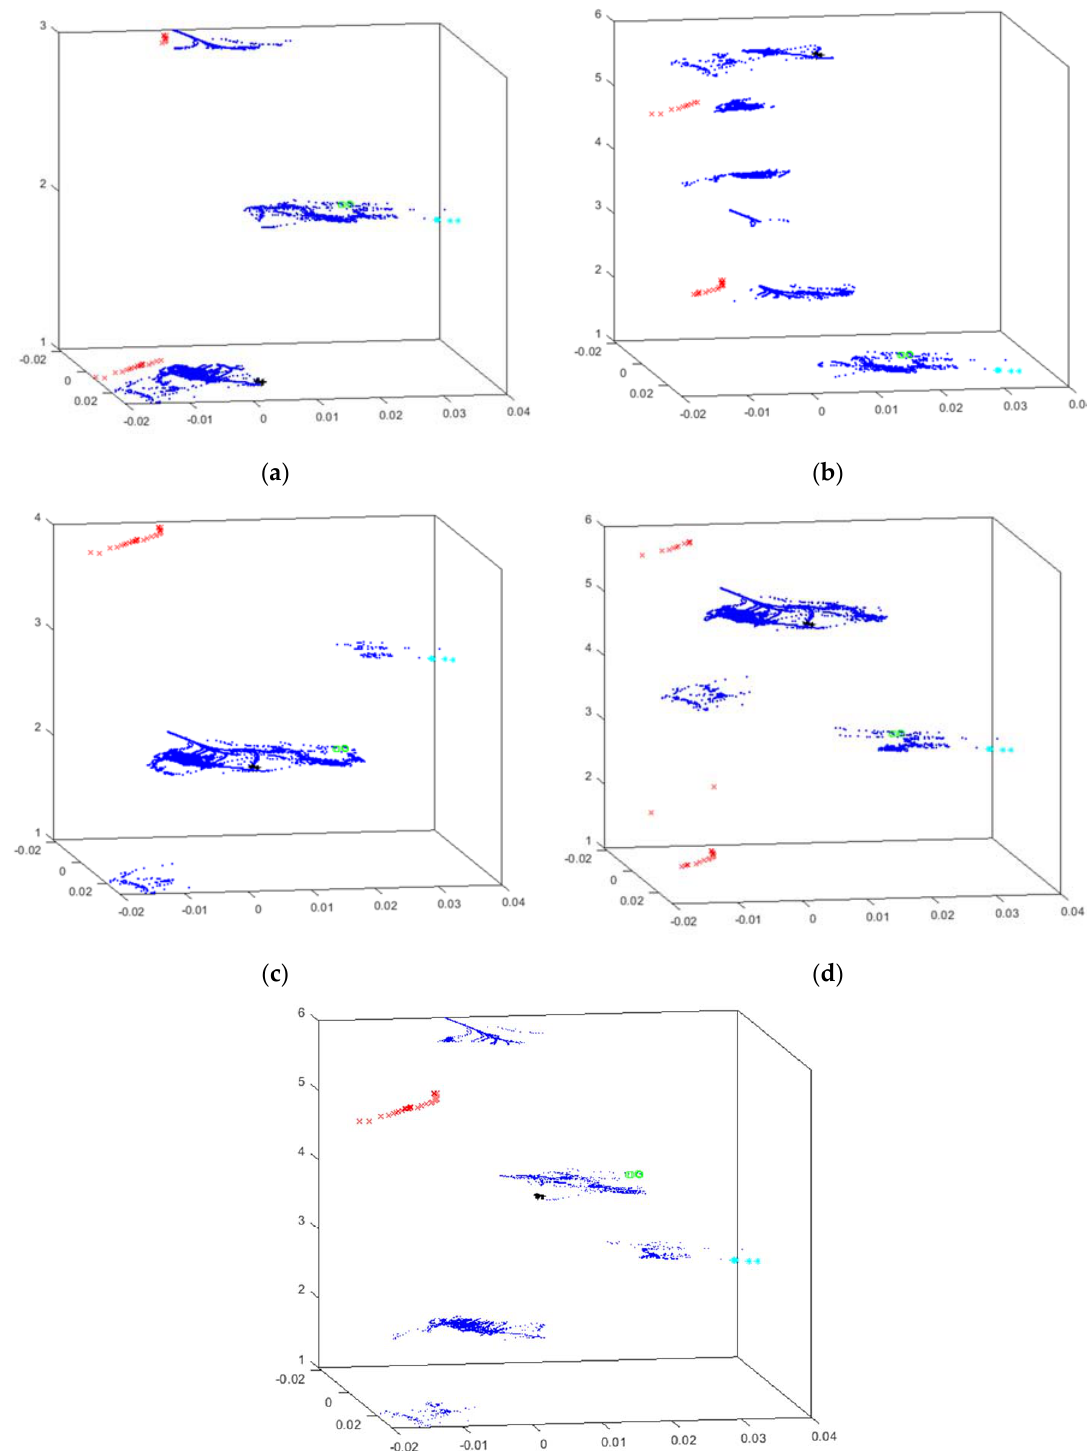
Figure 6. HUEP visualizations generated by CMDS–Cityblock and different clustering parameters of the intensifier dataset. ( a ) HUEP: CMDS–Cityblock+ k ‐ means ( k = 3 and Cityblock). ( b ) HUEP: CMDS– Cityblock+ k ‐ means ( k = 6 and Cityblock). ( c ) HUEP: CMDS–Cityblock+hierarchical clustering ( k = 4, Minkowski, and weighted). ( d ) HUEP: CMDS–Cityblock+hierarchical clustering ( k = 6, Chebyshev, and complete). ( e ) HUEP: CMDS–Cityblock+hierarchical clustering (k = 6, Cityblock, and complete).